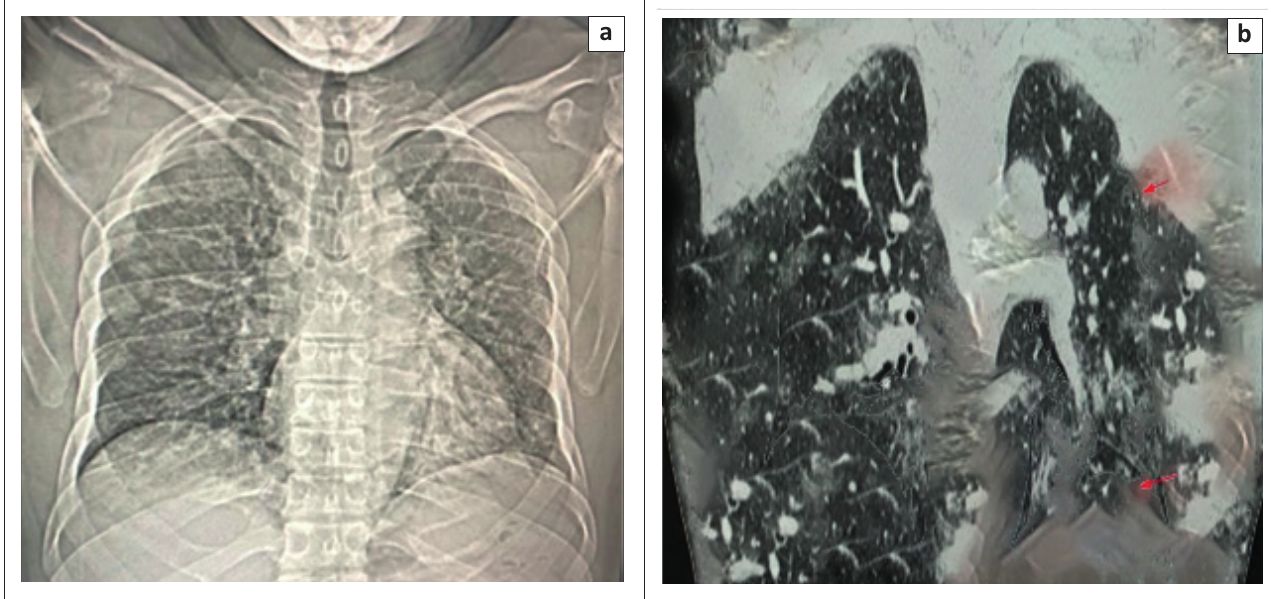
FIGURE 4: Radiological images of a 55 year old male patient with COVID-19 (37 Military Hospital, Accra, Ghana, May 2020). Case 3: (a) Postero-anterior chest x-ray showing bilateral ground-glass opacification and right upper and middle zone peripheral patchy opacities. (b) High resolution computerised tomography scan, coronal view, showing bilateral, ground-glass opacities with thickened interlobular and intralobular lines with ‘crazy paving’ appearance. Bilateral peripheral and subpleural opacities (red arrows).